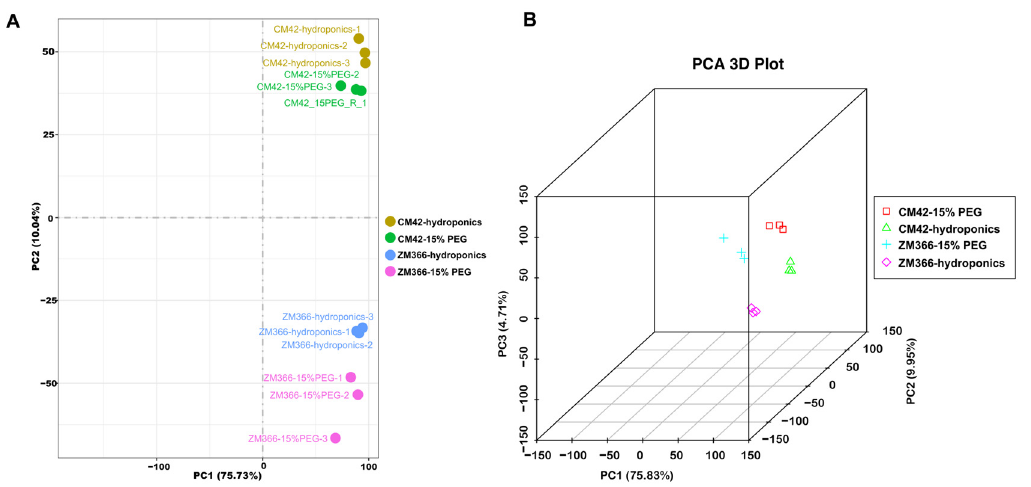
Figure 4. Principle Component Analysis (PCA) ( A ) CM42-hydroponics, CM42-15% PEG, ZM366- hydroponics, and ZM366-15% PEG PCA of a PCA 2D plot. ( B ) CM42-hydroponics, CM42-15% PEG, ZM366-hydroponics, and ZM366-15% PEG PCA of a PCA 3D plot. PC1 refers to the top contribution rate, which is the factor that has the greatest in fl uence on variation, and PC2 is the second factor.